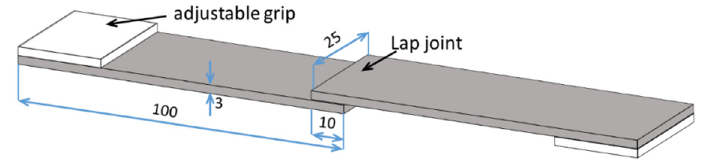
Figure 1. Schematics of the copper–epoxy–copper single lap joint prepared for the tensile shear test. Dimensions are given in mm.